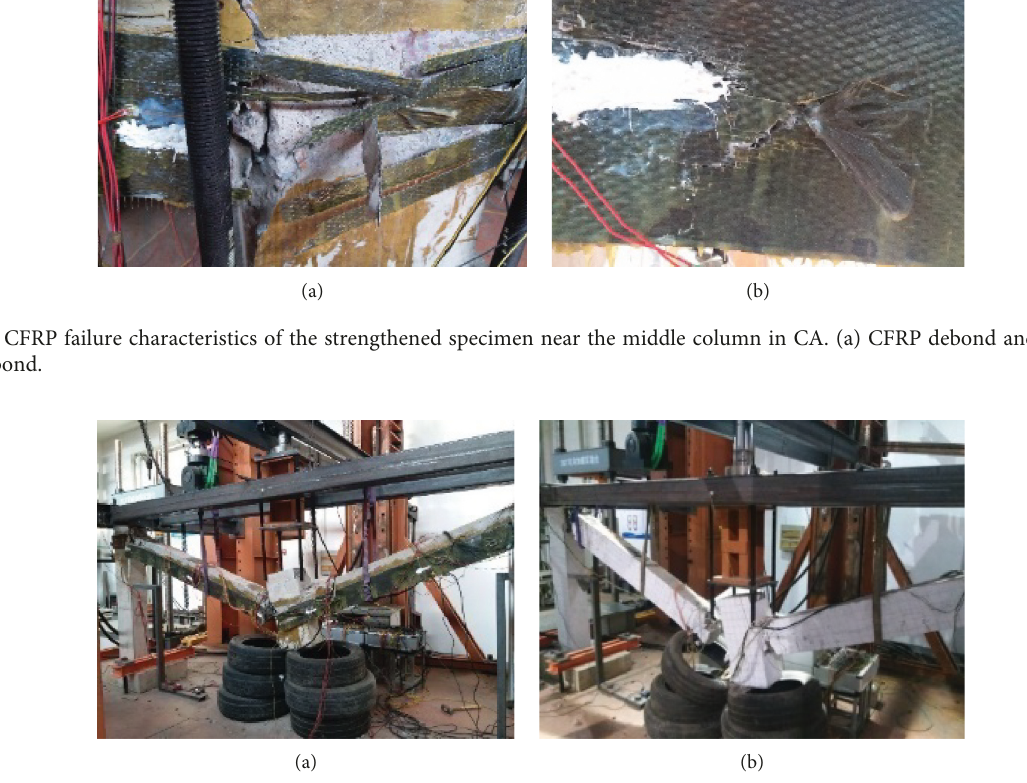
Figure 8: Collapse failure of the subassemblages. (a) CFRP strengthened specimen. (b) Unstrengthened specimen.